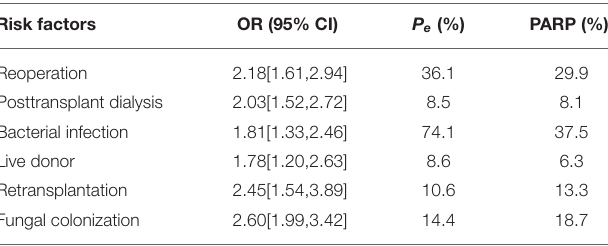
TABLE 3 | Population-attributable risk proportion of risk factors of invasive fungal infections in recipients after liver transplantation.